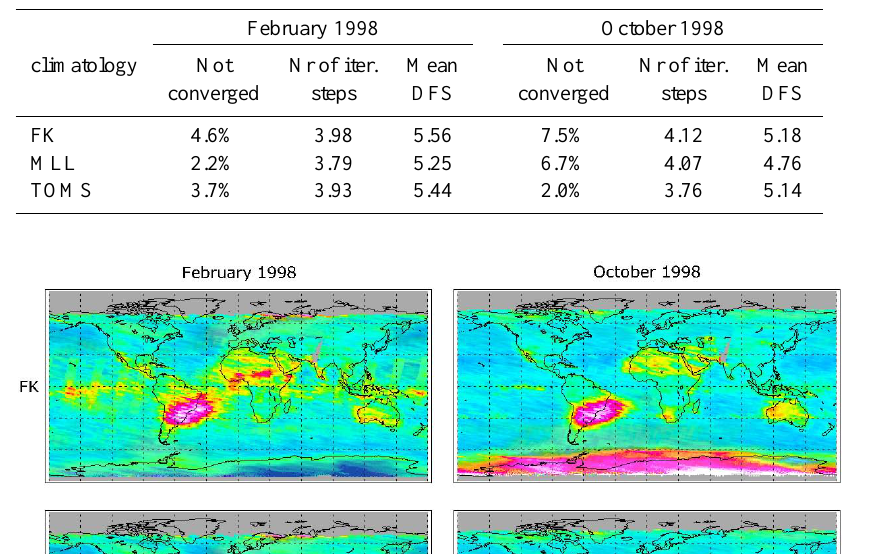
Table 3. Convergence statistics and mean DFS for different climatologies.